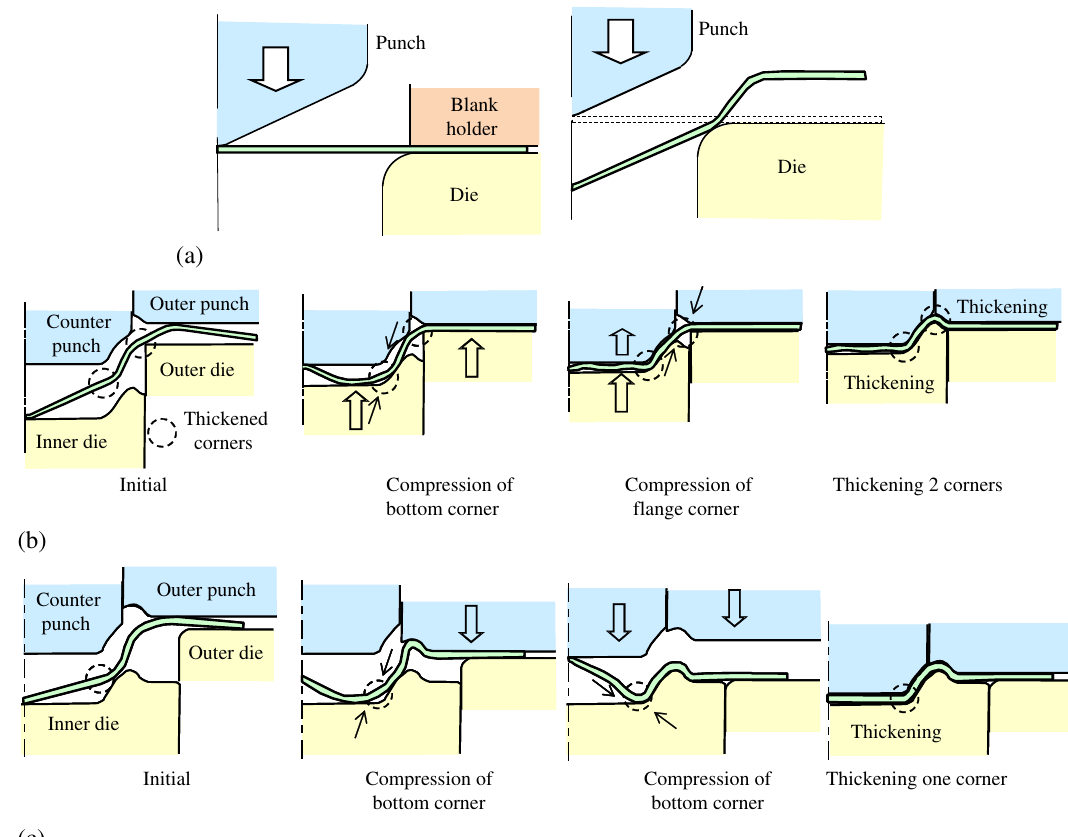
Figure 2. Plate forging of drawn cup with flange: (a) 1st and 2nd stages, (b) thickening of two corners and (c) thickening of one